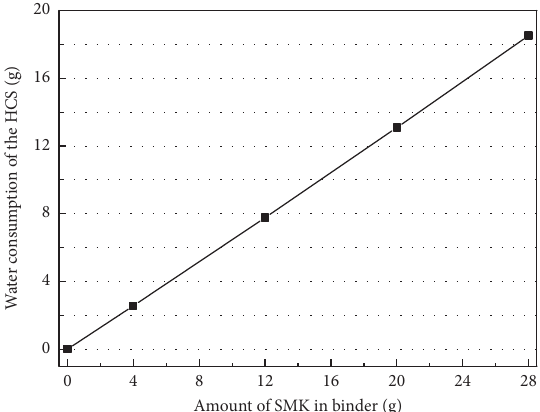
Figure 5: The relation between the water consumption of the HCS and the amount of the SMK added to the binder.